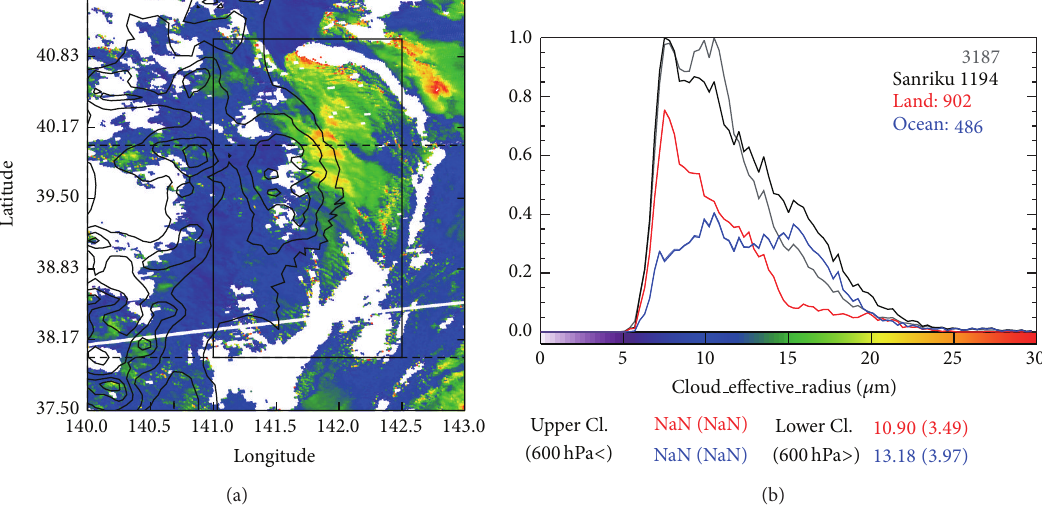
Figure 4: Same as Figure 3 but for effective cloud radius ( 𝑟 𝑒 ). The values in (b) indicate maximum values in each category (whole swath, Sanriku area (black box in (a)), and land and ocean in the Sanriku area). The values at the bottom of (b) show averages and standard deviations (in brackets) of the upper and lower clouds for land (red) and ocean (blue) in the Sanriku area.